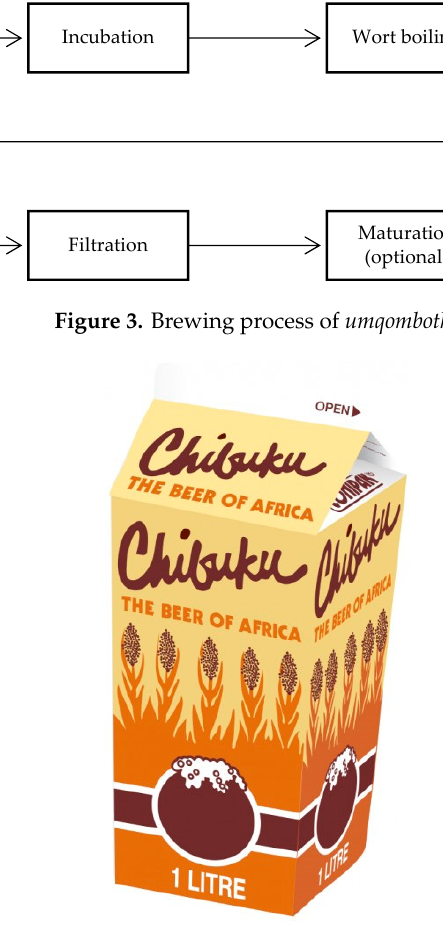
Figure 4. United National Breweries’ carton-packaged traditional beer.